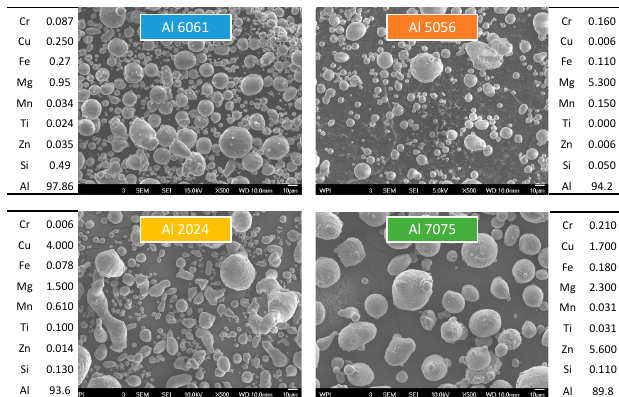
Figure 2. Chemistry associated with four of the gas-atomized alloyed Al powders studied herein.